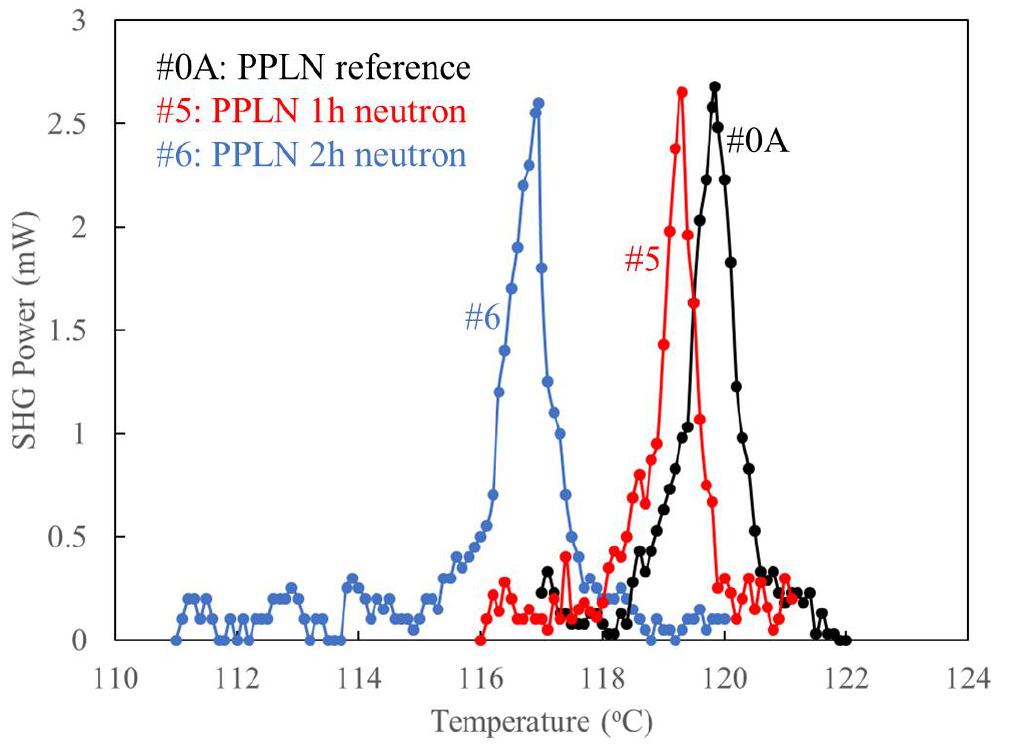
Figure 5. Phase-matching temperature tuning curve obtained for neutron-irradiated PPLN. Sample #0A is a reference PPLN crystal without any irradiation. Sample #5 and #6 are irradiation by THOR for 1 h and 2 h, respectively. The 60 Co gamma-irradiated sample (#4) has a similar temperature tuning curve with respect to sample #0A and is not shown in this figure.